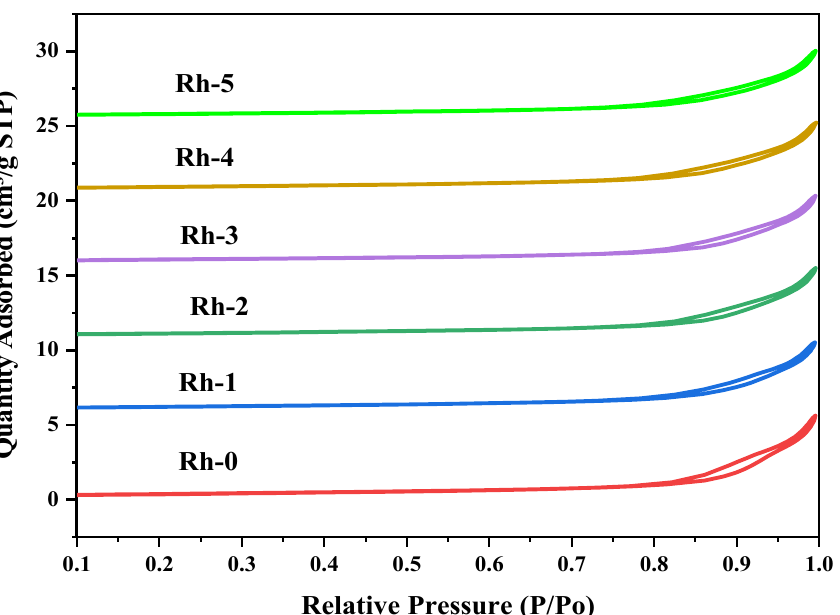
Figure 1. N 2 physisorption of Rh-x (x = 0, 1, 2, 3, 4, and 5 wt.%). Figure 2 exhibits the XRD patterns of the catalysts at 2 θ ° = 5 − 80 ° . The XRD pattern of yttria-stabilized zirconia support showed the cubic phase of zirconia (JCPDS No. 49-1642), which appeared at 2 θ = 30°, 35°, 50°, 60°, 63°, and 75°in reference to the (111), (200), (220), (311), (222), and (400), respectively, in all catalysts. Meanwhile, the peaks for NiO were at 37.2 ° and 43.1 ° . The XRD patterns for the Rh 2 O 3 -promoted samples were identical to those of the unpromoted one, denoting that the introduction of Rh 2 O 3 did not bring additional compounds. The absence of Rh 2 O 3 in the XRD patterns indicated its fine dispersion on the surface.